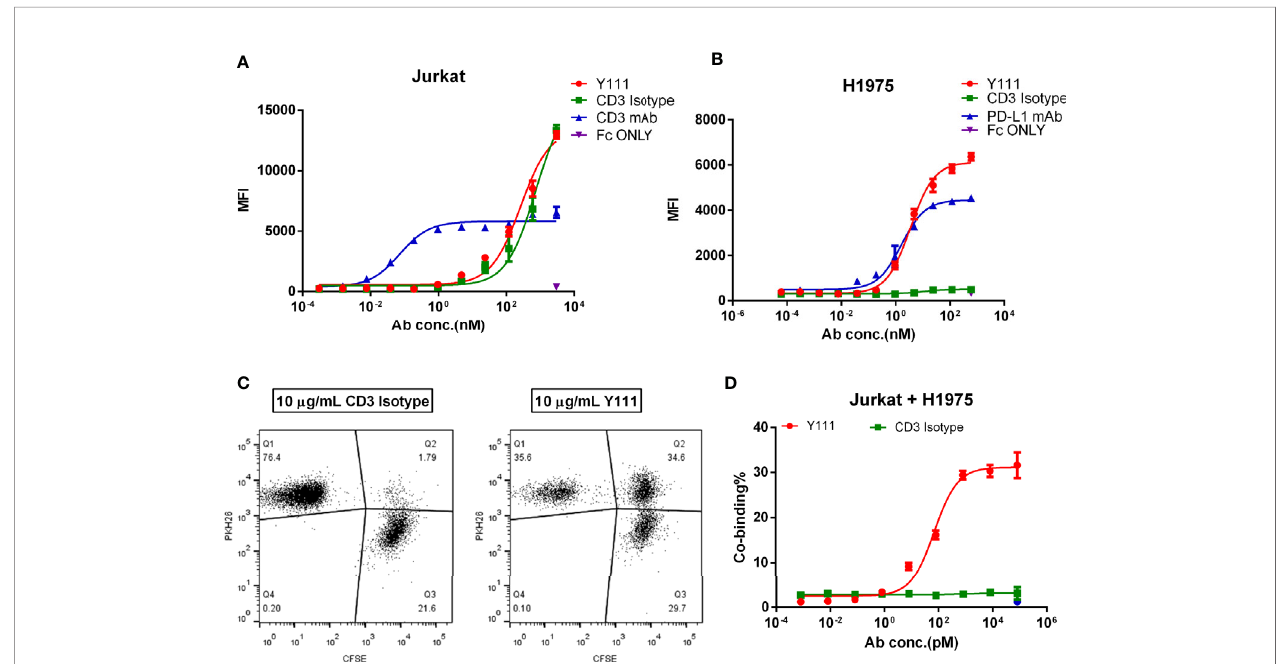
FIGURE 2 | Cell binding activities of Y111. (A, B) The binding af fi nity of Y111 to the CD3 expressed on the Jurkat cells (A) , and the PD-L1 expressed on the H1975 cells (B) . Flow cytometry was used to assess the geometric mean fl uorescence (MFI) of the PE channel, and data were analyzed using the “ One Site-Speci fi c binding ” method through the least-squares fi tting. Plotted dots were the means ± SEM of the triplicate wells from one of three independent experiments. (C, D) Y111 bridged the tumor cell and T cells in a dose-dependent manner. CFSE-stained H1975 cells were co-cultured with PKH26-labeled Jurkat cells with a dose of Y111 or CD3 Isotype for 1hour. Co-binding% was indicated as percentages of the CFSE and PKH26 double-positive cells (Q2) among cells. Representative co- binding dot plots were shown in (C) , a nonlinear regression depicting dose-dependent-association modulated by Y111was shown in (D) Data in (D) were represented as mean ± SEM pooled from four independent experiments, and were analyzed using the “ log (agonist) vs. response (three parameters) ” method through an ordinary fi tting. Y111, a bispeci fi c antibody targeting CD3 and PD-L1; CD3 Isotype, a control bispeci fi c antibody targeting CD3 and fl uorescein; CD3 mAb and PD-L1 mAb, the parental monoclonal antibody targeting CD3 and PD-L1; Fc only, adding the PE-hFc